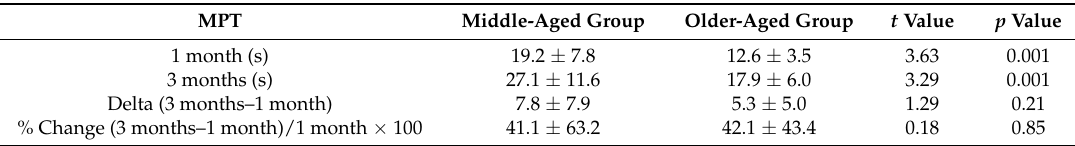
Table 2. MPT from 1 month to 3